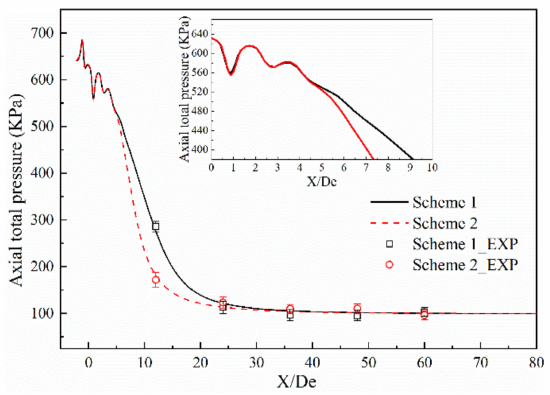
Figure 6. Comparison of axial total pressure between the combustion experiment results and the numerical simulation results. Table 4. Velocity and total pressure at the monitoring points.